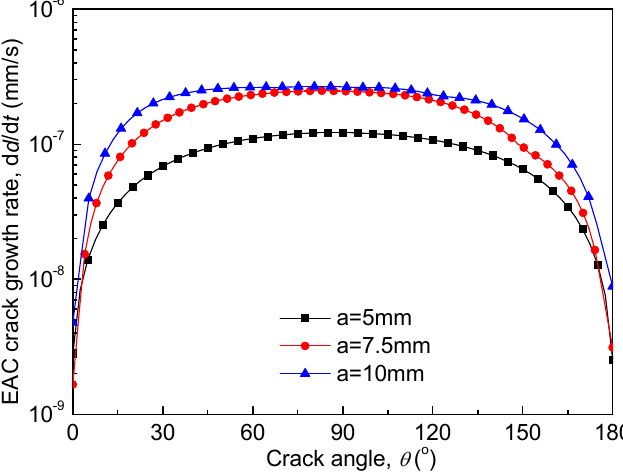
Figure 12: Crack growth rate of Alloy 182 in the DMW